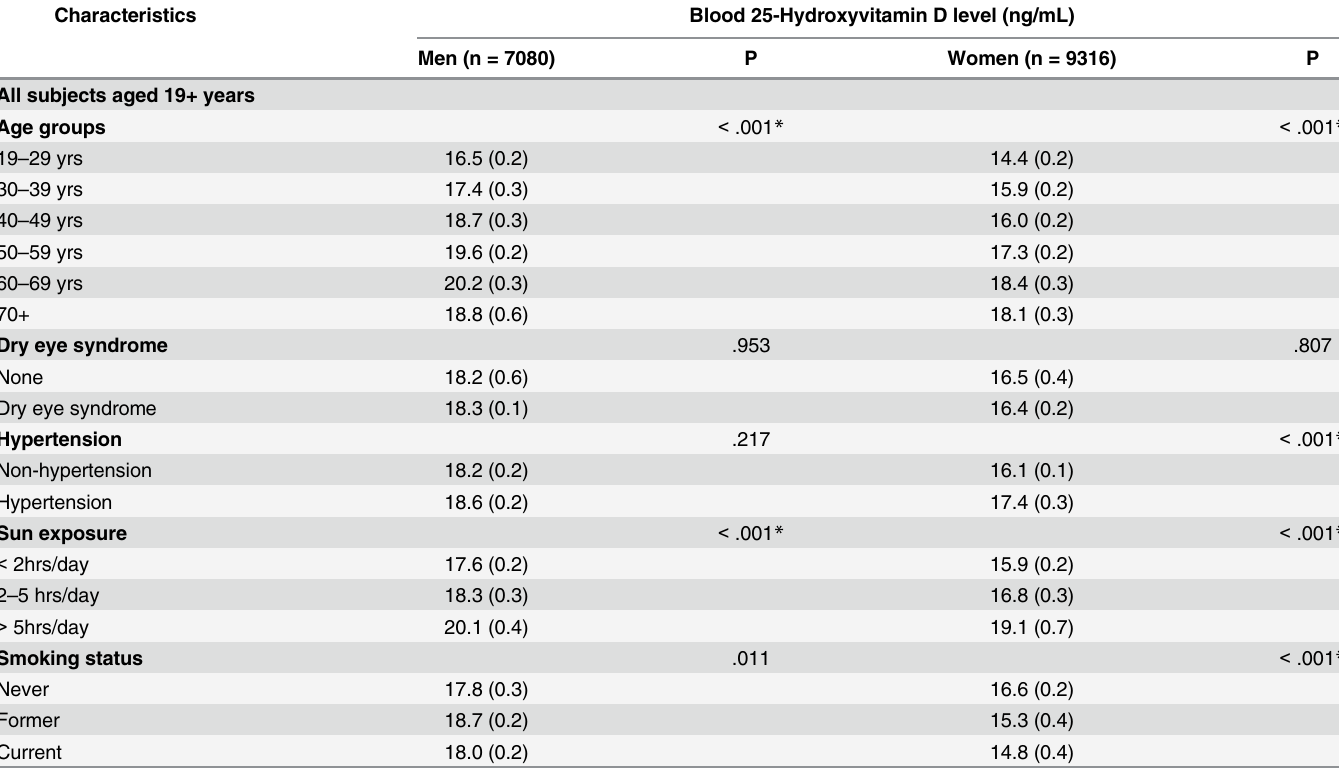
Table 3. Gender difference of blood 25-Hydroxyvitamin D levels (ng/mL) of men and women according to age group and other variables among representative Korean adults aged 19 years or older. Blood 25-hydroxyvitamin D levels were expressed as weighted estimates [%] (standard errors [%], 95% confidence intervals).